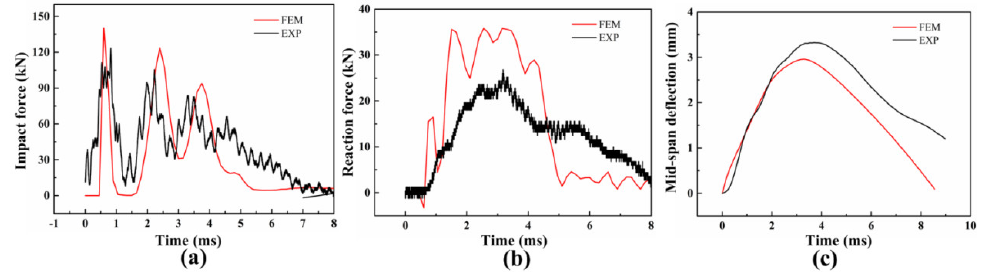
Figure 8. The comparison of ( a ) impact force; ( b ) reaction force; and ( c ) mid−span deflection time curves between experimental and numerical results. curves between experimental and numerical